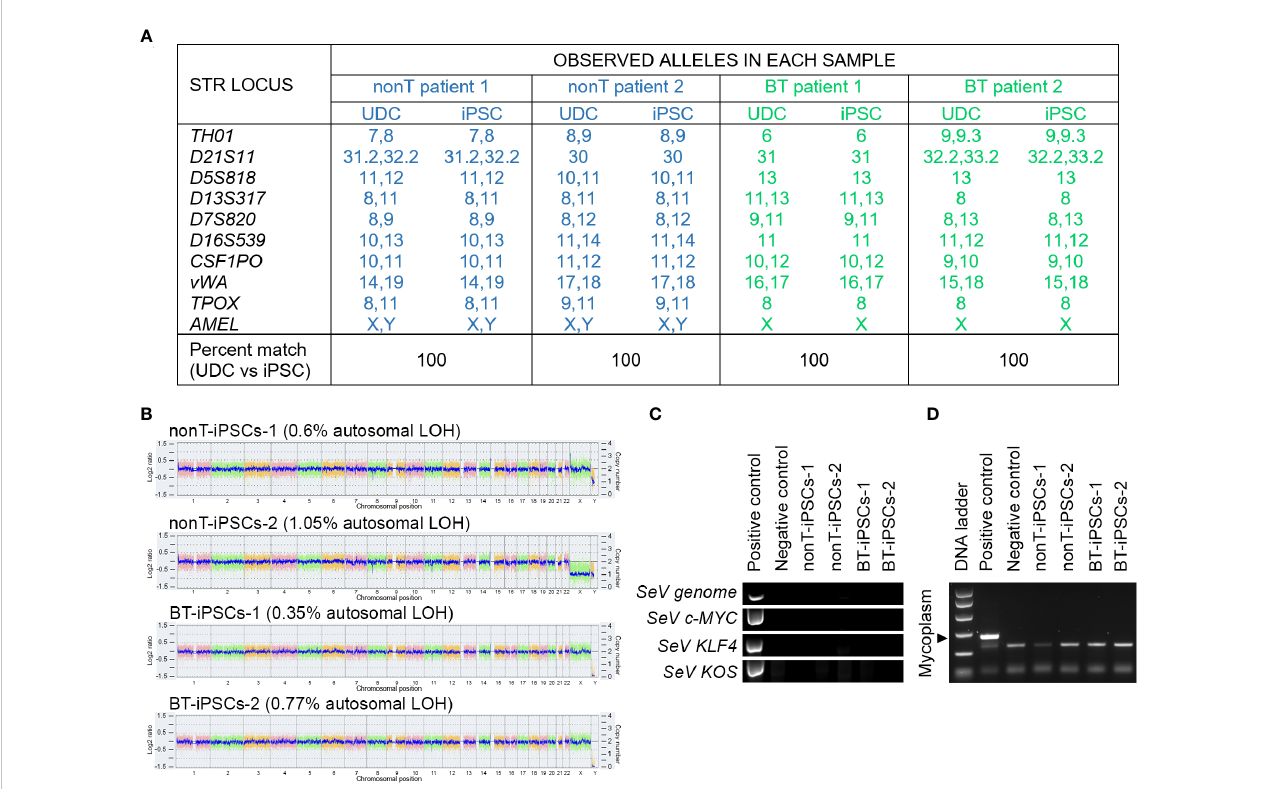
FIGURE 5 Authentication, molecular karyotyping, virus clearance and mycoplasma testing of established iPSCs. (A) DNA fi ngerprint analysis showing that the allele pattern in the iPSCs generated is 100% concordant with the patients ’ UDCs and it is not concordant with any commercial cell line whose genotype is posted in public databases. The STR locations studied were: TH01, D21S11, D5S818, D13S317, D7S820, D16S539, CSF1PO, vWA, TPOX and AMEL . The percentage of matching between iPSCs and their parental UDCs is indicated for each sample. (B) Whole genome view of the iPSC lines which displays all somatic and sex chromosomes in one frame. The smooth signal plot (right y-axis) is the smoothing of the Log2 ratios (left y-axis), which depict the signal intensities of probes on the microarray and represents the number of copies of each chromosome. The pink, green and yellow colors represent the raw signal for each individual chromosome probe, and the blue signal represents the normalized probe signal, used to identify copy number and any aberrations. The percentage of autosomal loss of heterozygosity (LOH) is indicated for each cell line. (C) RT-PCR analysis showing the absence of expression of Sendai virus (SeV) genome and OSKM transgenes in the established iPSC lines. UDCs served as negative control and recently transfected iPSCs served as positive control. (D) PCR test for mycoplasma detection, showing the absence of contamination in cultured iPSC